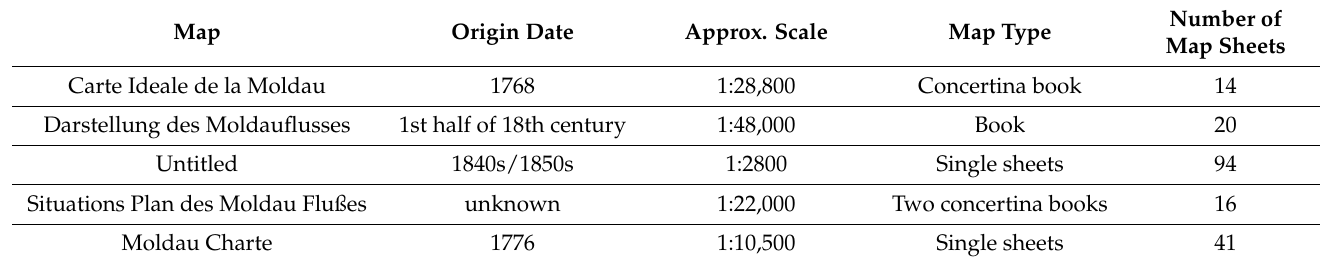
Table 1. Manuscript river maps of the Vltava River, Source: author’s